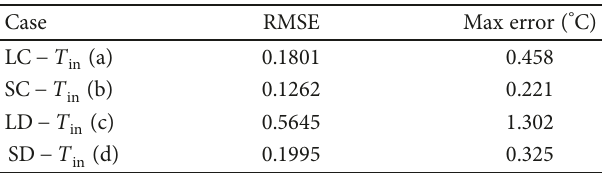
LC − T SC − T LD − T SD − T in ; (b) in ; (c) in ; (d) in . Table 4: Estimation errors for four validation data by using the solo linear NN